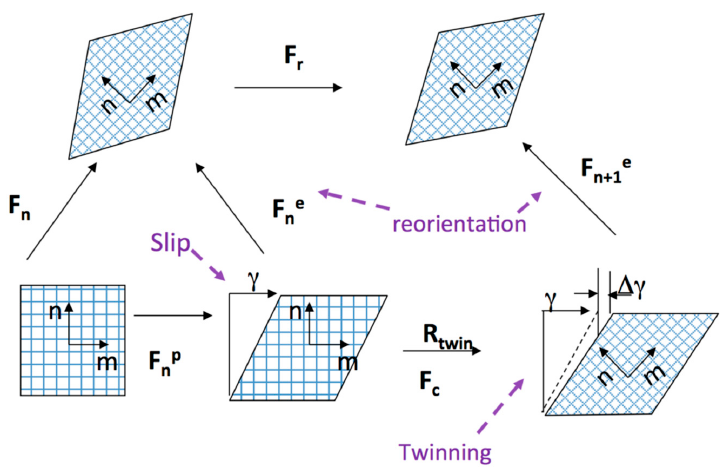
Figure 5. The deformation modes kinematics in finite strain framework (After Yaghoobi et al. [103]).